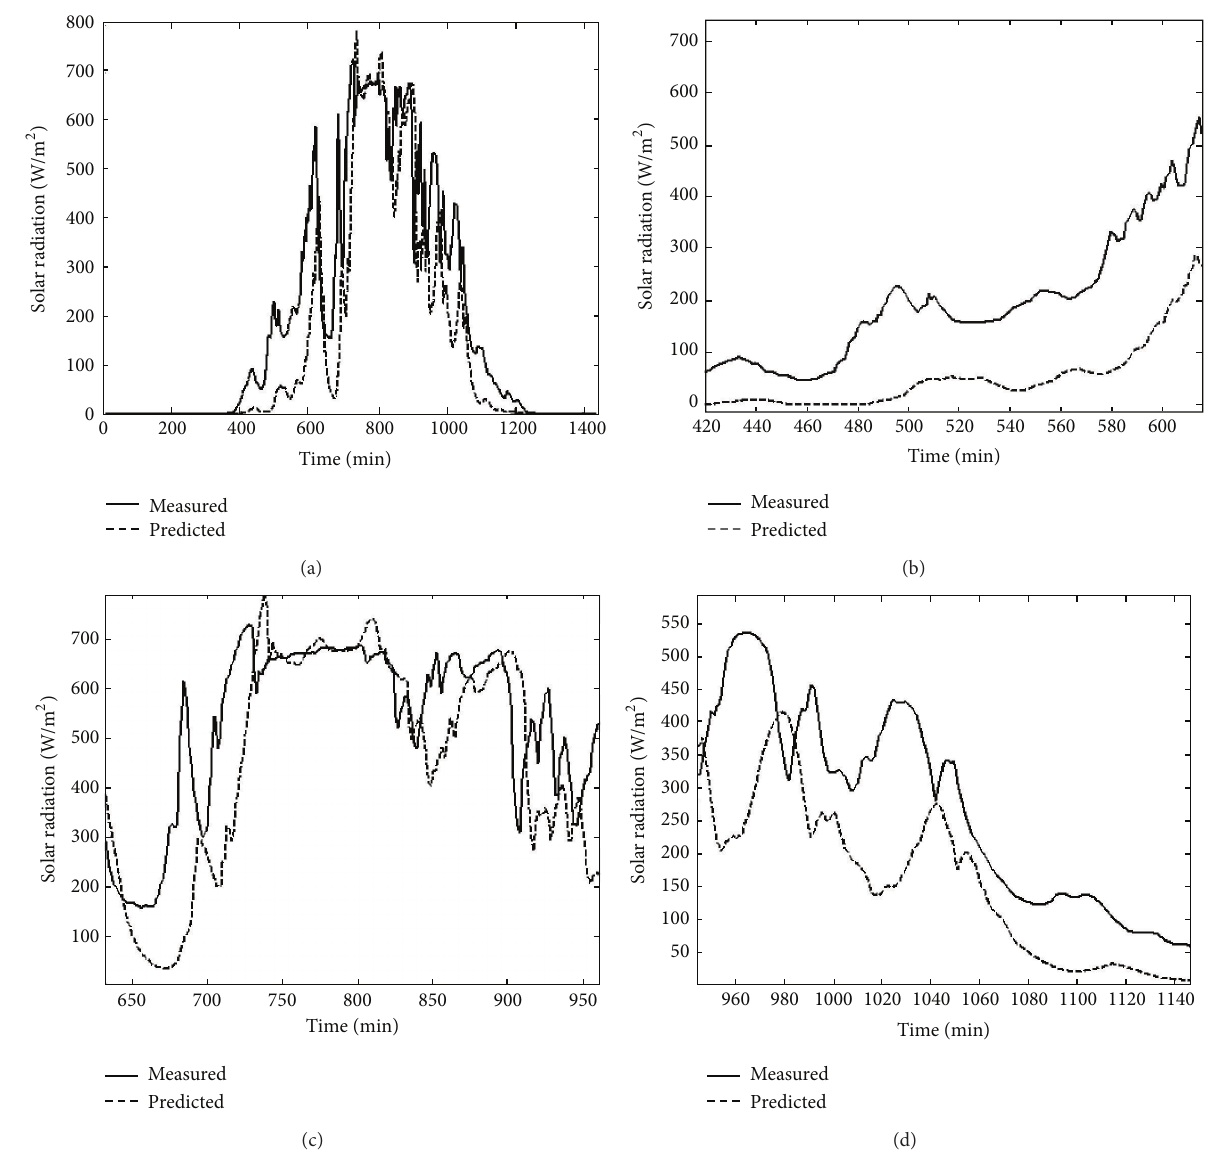
Figure 11: Sixty-step ahead solar radiation prediction for one day using a hybrid SVR/Markov with four states. (b), (c), and (d) represent zooming images of (a). Table 8: Obtained average prediction values for ten days selected from April to May of 2000 ( spring ). Model